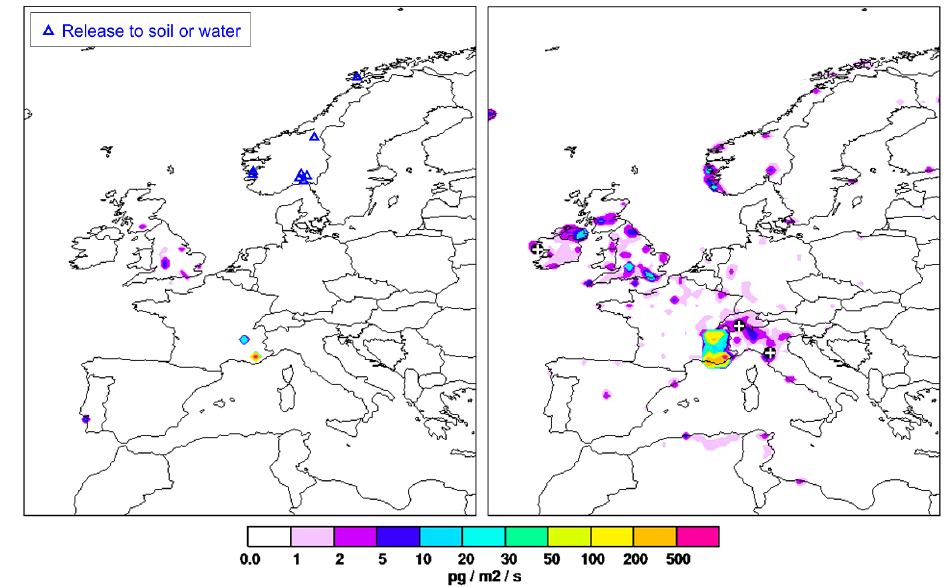
Figure 4. Left: red dots represent 2008 MCF emissions as reported by the E-PRTR database. The blue triangles correspond to declared release to soils and water not included in our a priori emission field. Right: a posteriori study domain emission in pgm − 2 s − 1 of MCF based on measurements at three European sites. Reference period: January 2008–December 2008. White crosses over black dots indicate the locations of the measurements sites. Table 2. MCF emission estimates expressed in Ggyr − 1 for years 2002–2012. Errors are given in